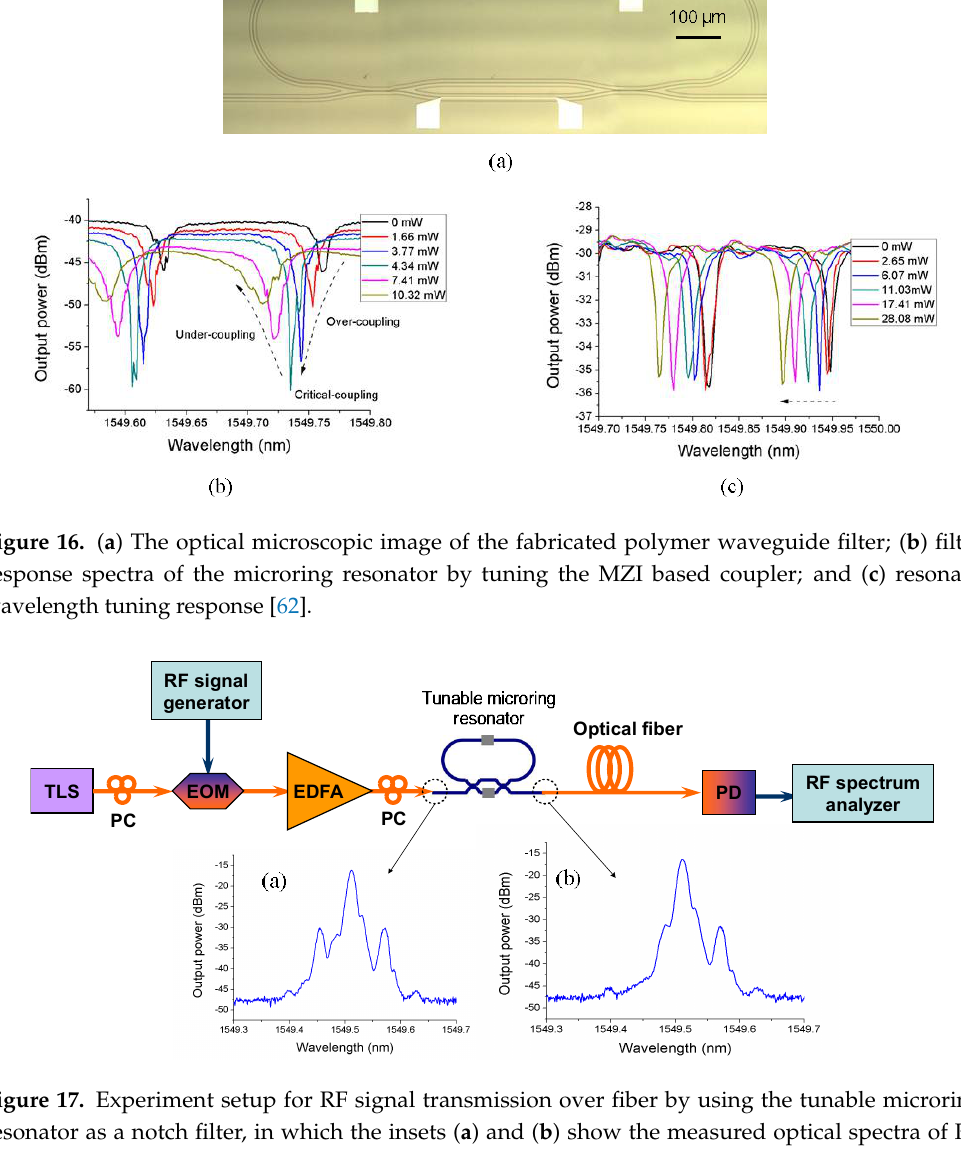
Figure 17. Experiment setup for RF signal transmission over fiber by using the tunable microring resonator as a notch filter, in which the insets ( a ) and ( b ) show the measured optical spectra of RF modulated lightwave before and after the microring resonator [62].